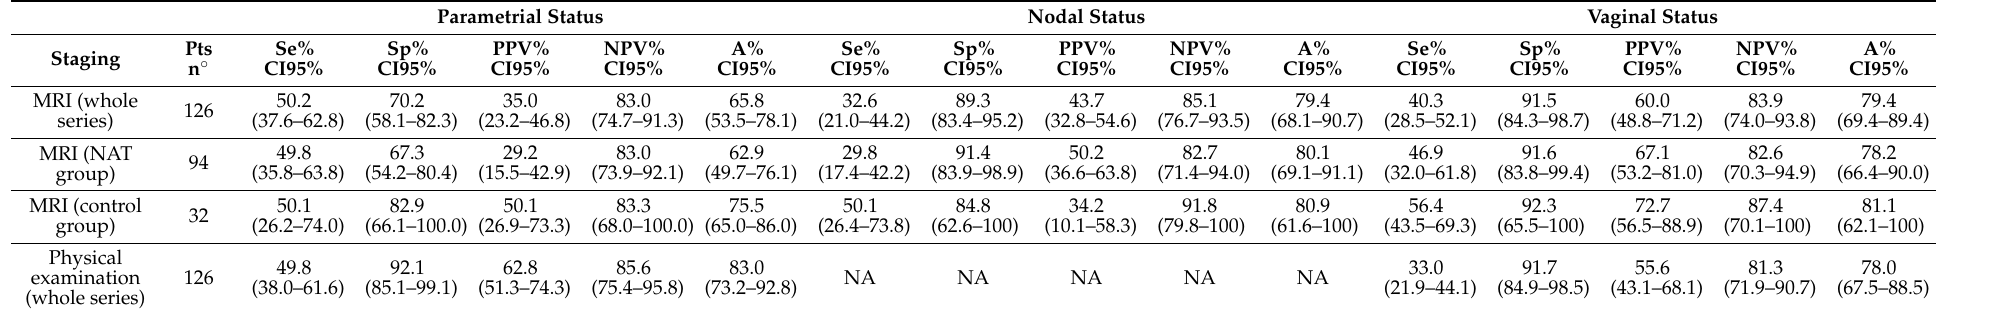
Table 2. MRI and physical examination staging in pre-treated and not pre-treated patients affected by cervical